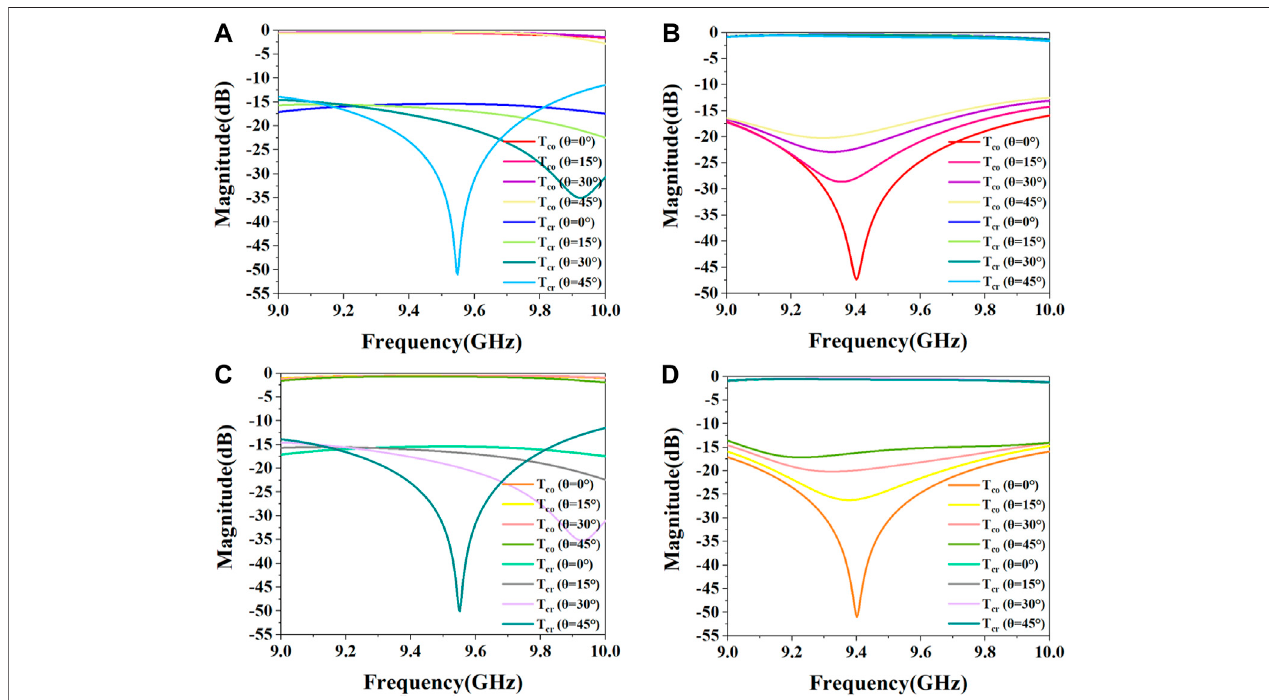
FIGURE5 |(A,B) are thecontinuouspolarization angle rotationability ofthe designed DPM unit at TEpolarizedwavesoblique incidence. (C,D) are thecontinuous polarization angle rotation ability of the designed DPM unit at TM polarized waves oblique incidence. (A) The co-polarized transmissivity (T co ) and the cross-polarized transmissivity (T cr ) without rotating the DPM with different incident angle θ . (B) The co-polarized transmissivity (T co ) and the cr-polarized transmissivity (T cr ) with the DPM rotating 45 ° with different incident angle θ . (C) The co-polarized transmissivity (T co ) and the cr-polarized transmissivity (T cr ) without rotating the DPM with different incident angle θ . (D) The co-polarized transmissivity (T co ) and the cr-polarized transmissivity (T cr ) with the DPM rotating 45 ° with different incident angle θ